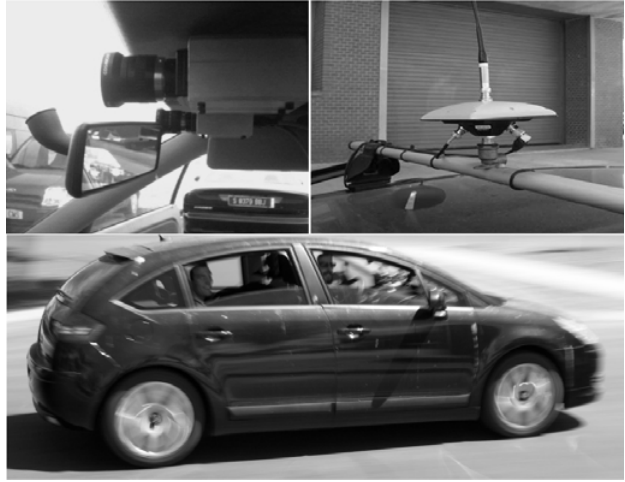
Figure 1. (Top left) Low cost stereo vision sensor. (Top right) RTK-DGPS. (Bottom) Experimental vehicle (modified Citröen